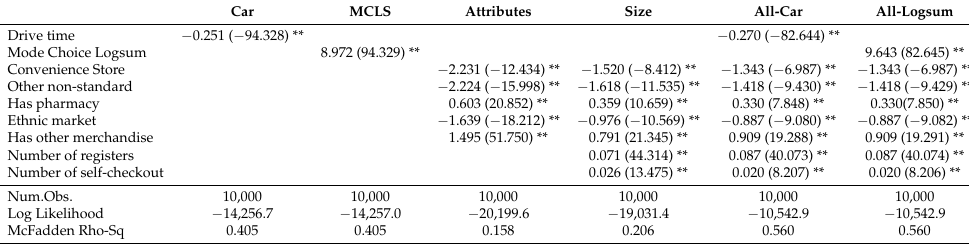
Table 3. Grocery Destination Choice Utilities.